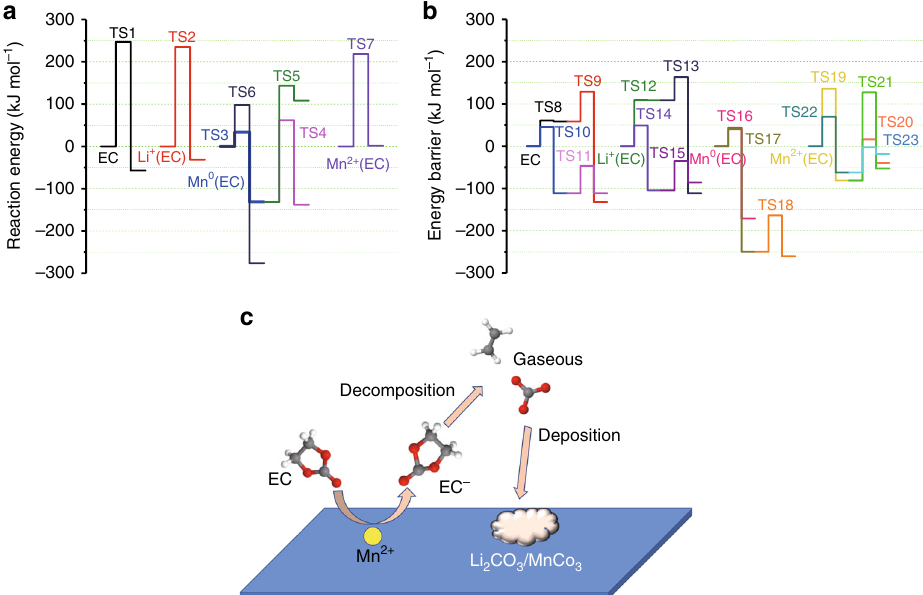
Fig. 4 In fl uence of Mn 2 + species on the decomposition mechanism of electrolyte. Decomposition reaction pro fi les of EC with and without interacting with Li + , metallic Mn and Mn 2 + before ( a ) and after one electron reduction ( b ) from DFT calculation; Catalytic mechanism of Mn 2 + on the reduction decomposition of electrolytes ( c